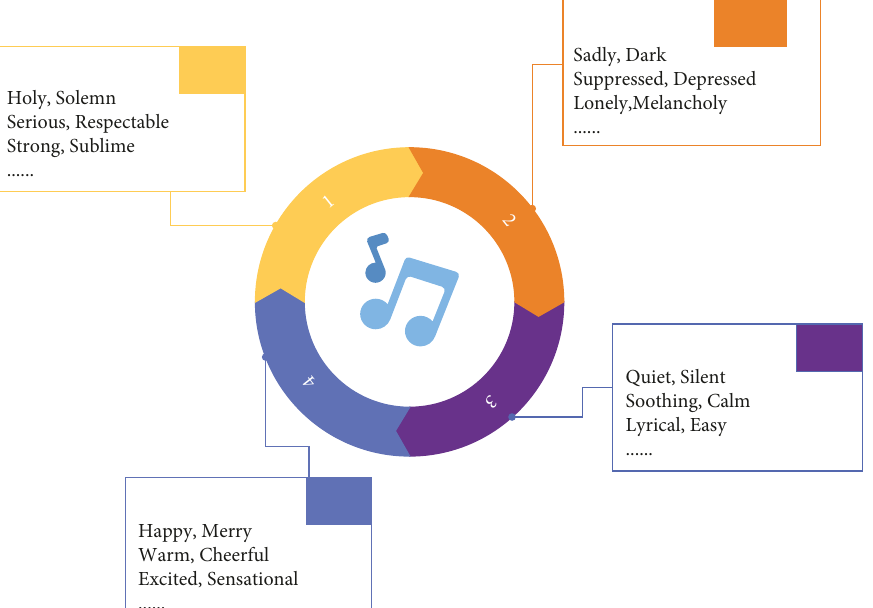
Figure 6: Music sentiment analysis model.